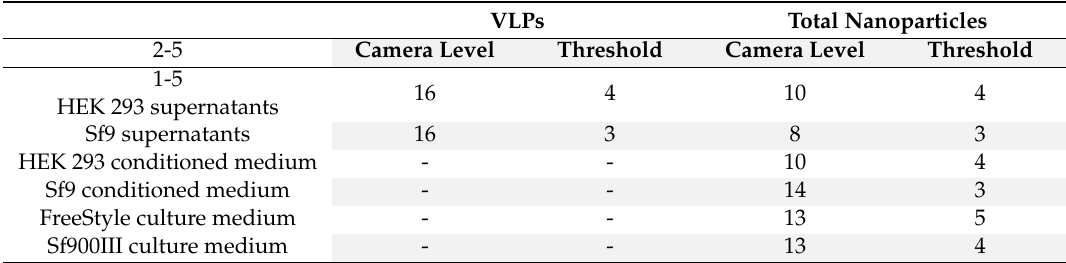
Table 1. NTA analysis